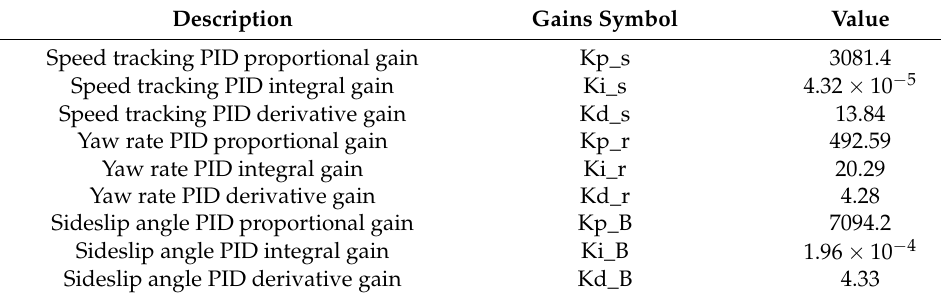
Table 1. Gains of Optimized PID